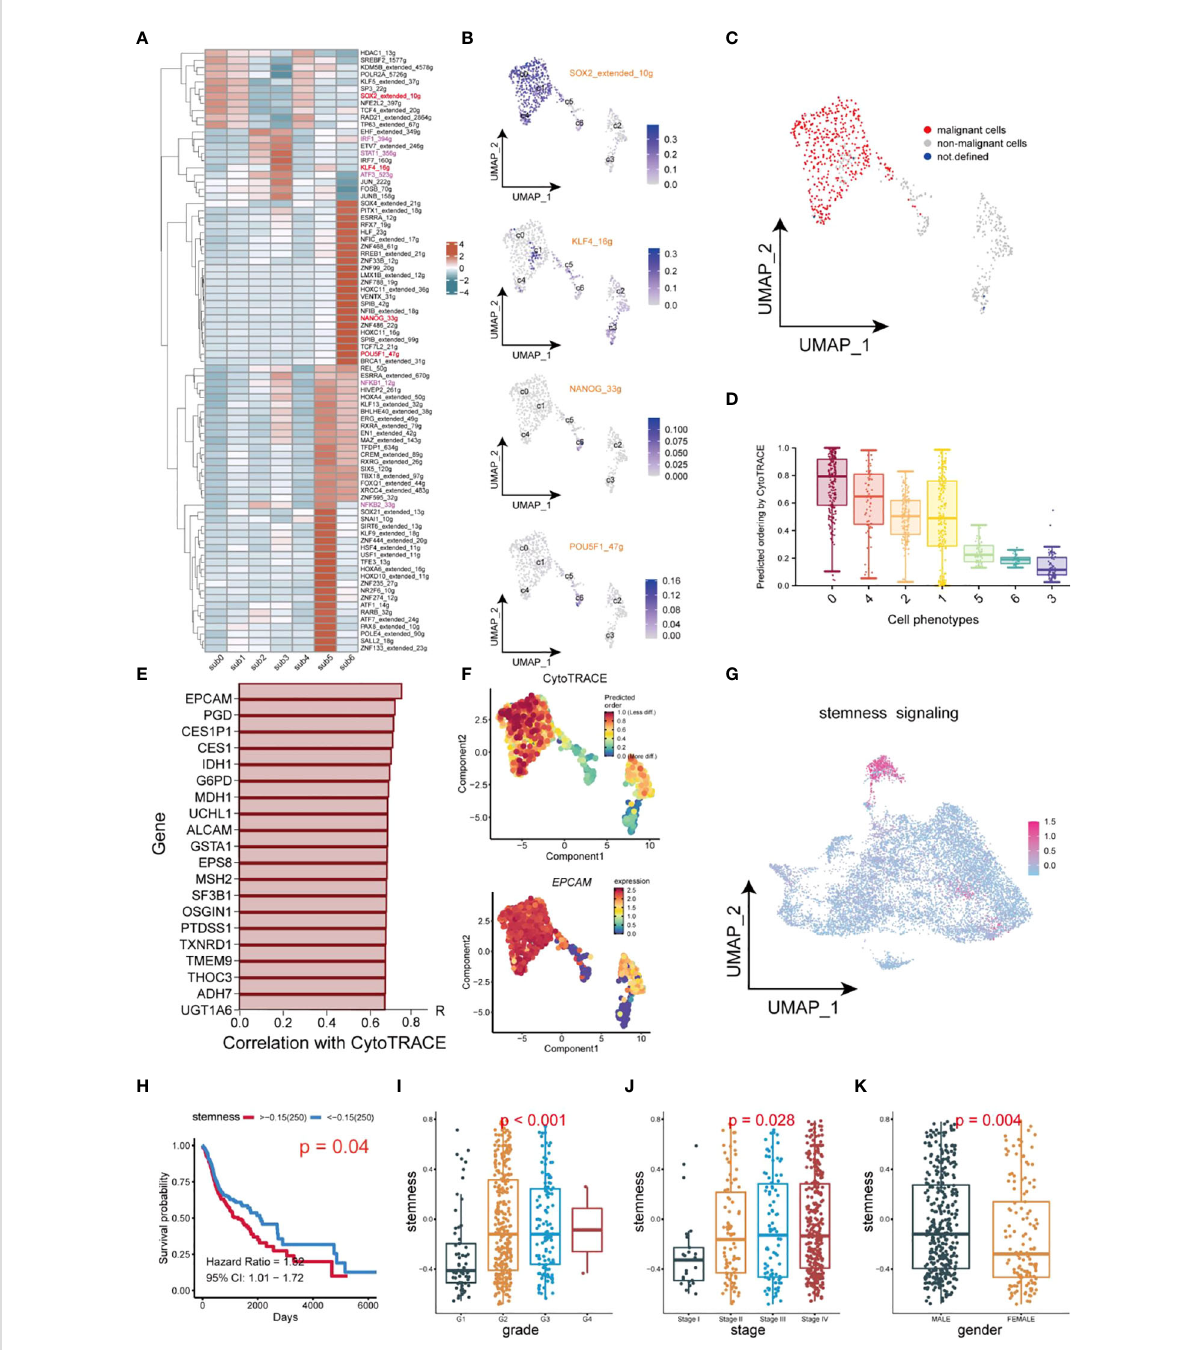
FIGURE 6 Transcription factor identi fi cation and stemness assessment in CSCs. (A) Heatmap of expression of transcription factors in different subsets of CSCs. (B) UMAP plot of distribution of SOX2, KLF4, NANOG, OCT4 (POU5F) in different subsets of CSCs. (C) UMAP plot of distribution of malignant cells and non-malignant cells in CSCs. (D) Box plots of stemness. (E) Top 20 genes which are positive correlation with CytoTRACE. (F) UMAP plot of intensity of stemness in different subsets of CSCs. (G) UMAP plot of distribution of stemness signals in cancer cells. (H) Plot of Kaplan-Meier survival analysis. (I – K) Box plot of analysis of the differences in stemness levels between different clinical